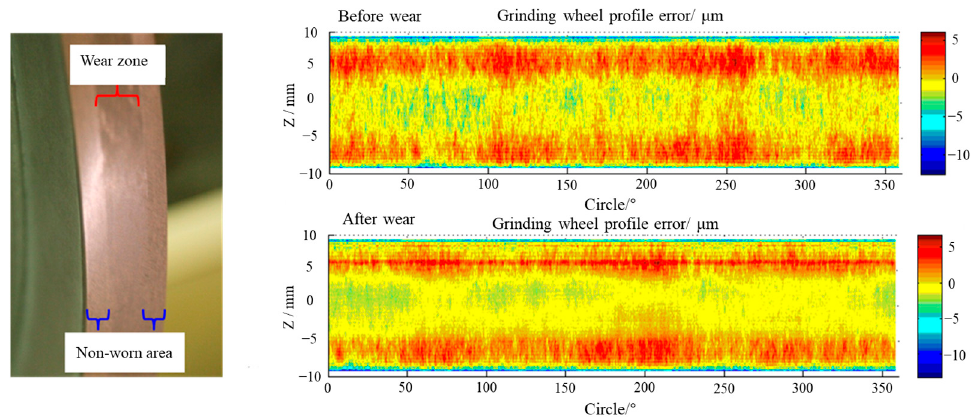
Figure 3. Macroscopic wear morphology of a silicon carbide grinding wheel. (b) Wear pa tt ern and life prediction of silicon carbide grinding wheels.